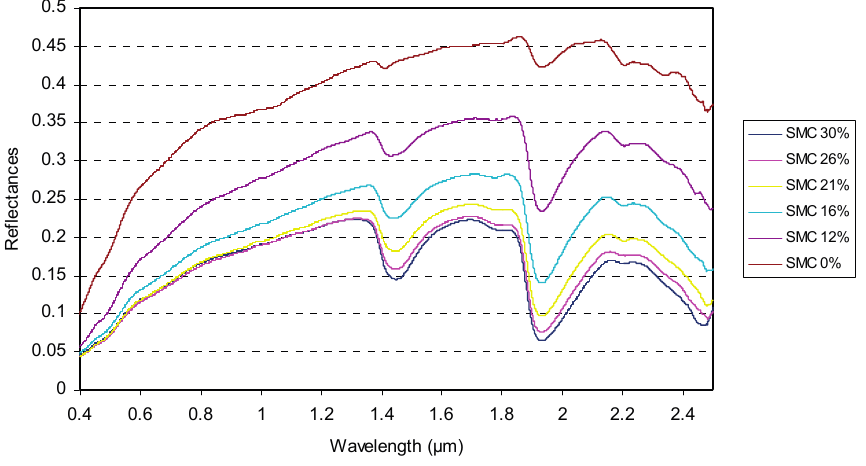
Figure 1. Spectral signatures according to SMC (in %g) for a soil sample of the area name 30Camargue (Table